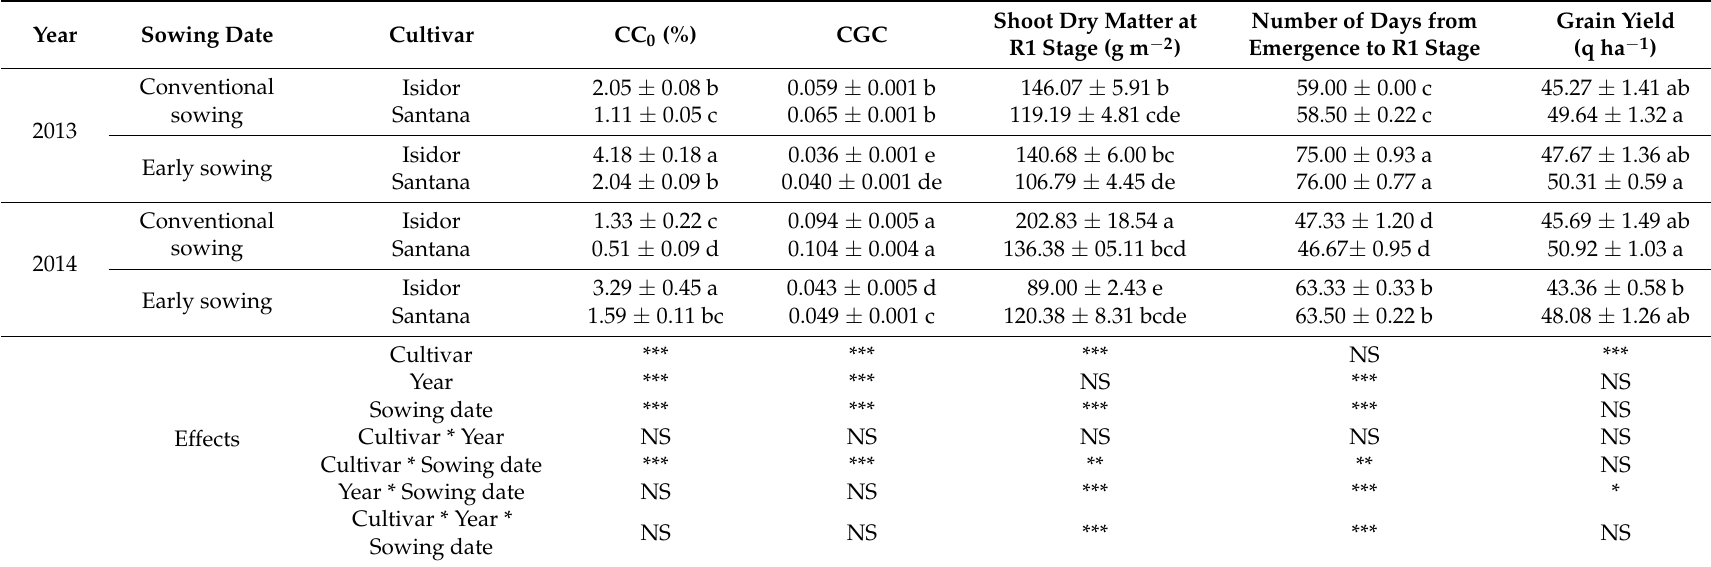
Table 4. Canopy cover parameters, total shoot dry matter at the R1 stage, number of days from emergence to the R1 stage, and grain yield of two soybean cultivars for conventional and early sowing in 2013 and